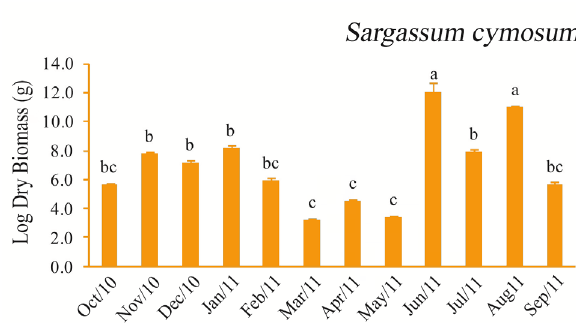
Figure 3. Monthly values of mean dry biomass (± standard error) of Sargassum cymosum fronds . Bars with the same letter show no statistical